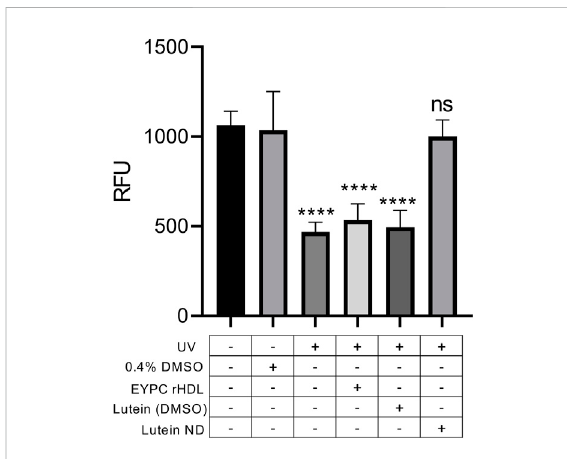
FIGURE 6 EffectofluteinNDonUVirradiation-inducedROSgeneration in cultured ARPE-19 cells. Cells were incubated for 72 h in media only,mediaplus0.4%DMSO,EYPCrHDL,lutein(8.8 μ MinDMSO), andluteinND(8.8 μ Maslutein).Followingincubation,cellsin indicatedtreatmentgroupswereexposed toUVirradiation for2 h. Following irradiation, cellular ROS levels were determined. For assay readout, sample fl uorescence emission was measured at 535 nm (excitation 485 nm). Statistical values reported are the mean ± standard error ( n = 10); ** = p < 0.01 vs. control, *** = p